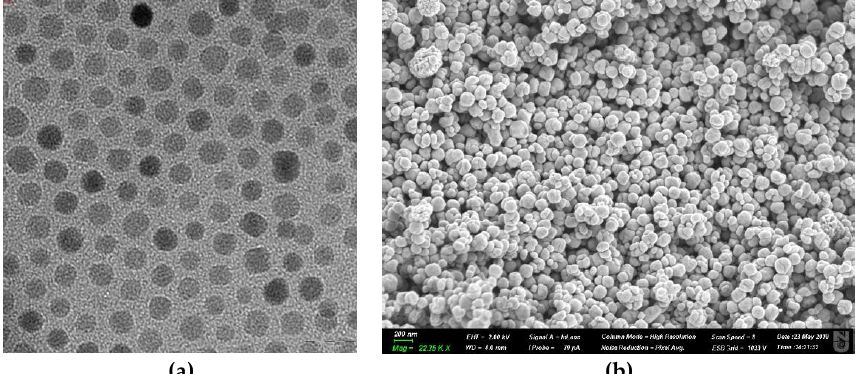
Figure 5. ( a ) The TEM image of iron oxide magnetic nanoparticles (MNPs) synthesized by the thermal decomposition method; ( b ) The SEM image of the iron oxide magnetic nanoparticles synthesized using a solvothermal method.